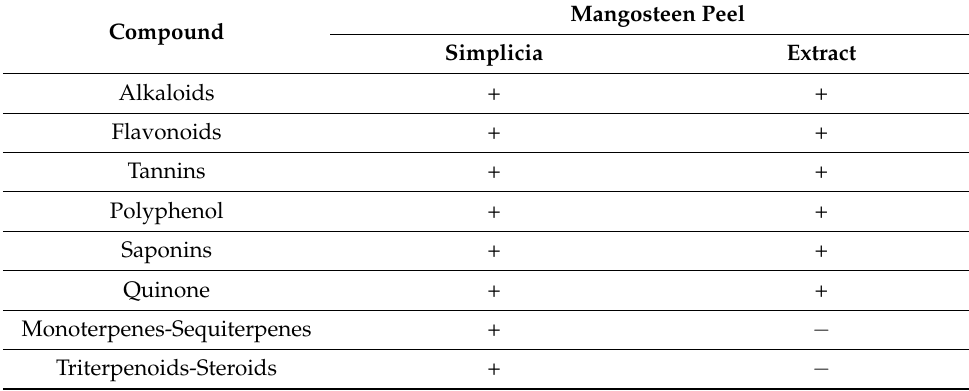
Mangosteen Peel Simplicia Extract